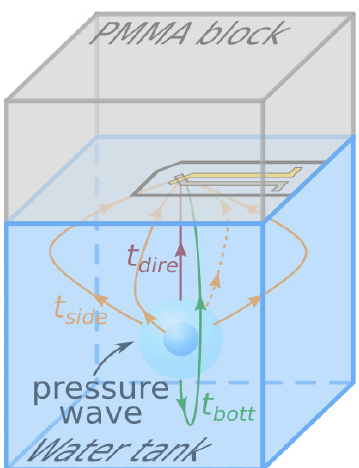
Figure 6. Schematic diagram of direct propagation of pressure wave and multiple reflections. The red path is the direct propagation, the orange paths are sidewall reflections and the green path is the bottom reflection, the time required for the propagation are, respectively, t dire , t side and t bott